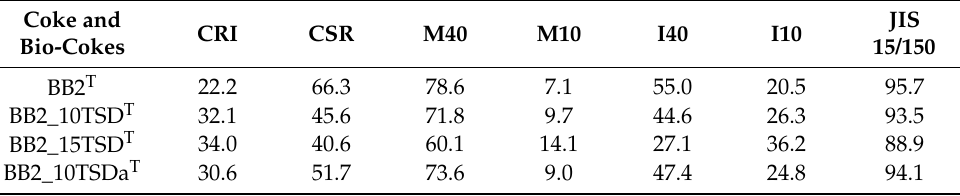
Table 6. Coke Reactivity Index, CRI, and Coke Strength after Reaction, CSR, and mechanical strength according to different standards for the coke carbonized in technical scale.